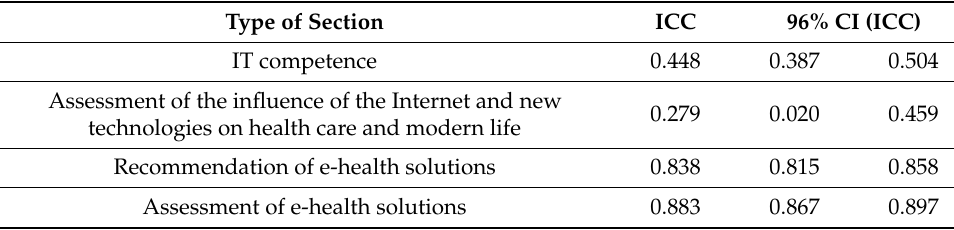
Table 1. Intraclass correlation coefficient calculated for each type of questionnaire section. Type of